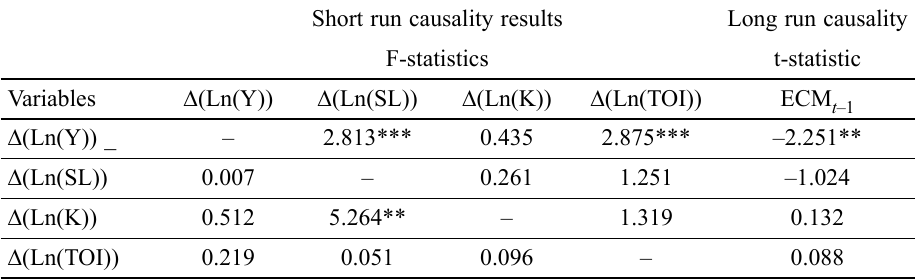
Table 5. Granger causality